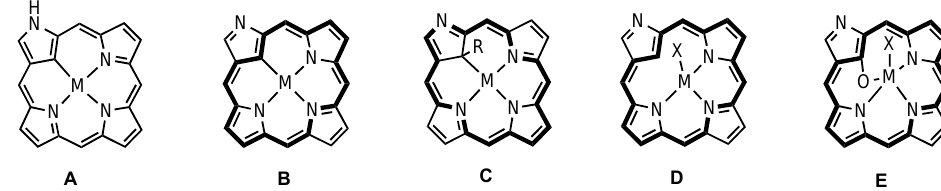
Figure 3. Coordination modes exhibited by N-confused porphyrins.